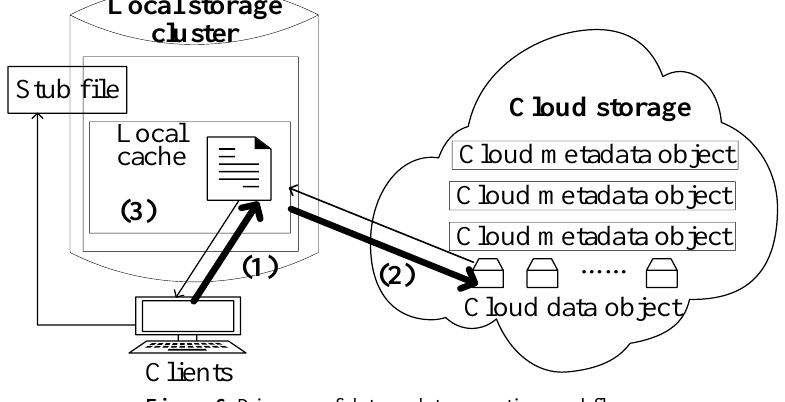
Figure 6. Diagram of data update operation